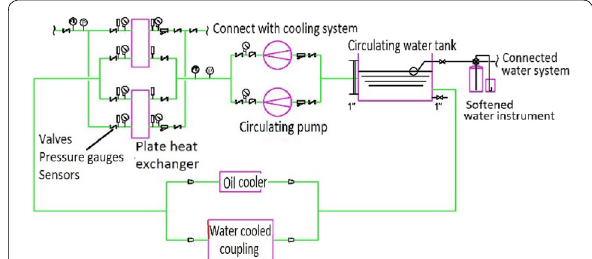
Figure 11 Water cooling coupling experimental